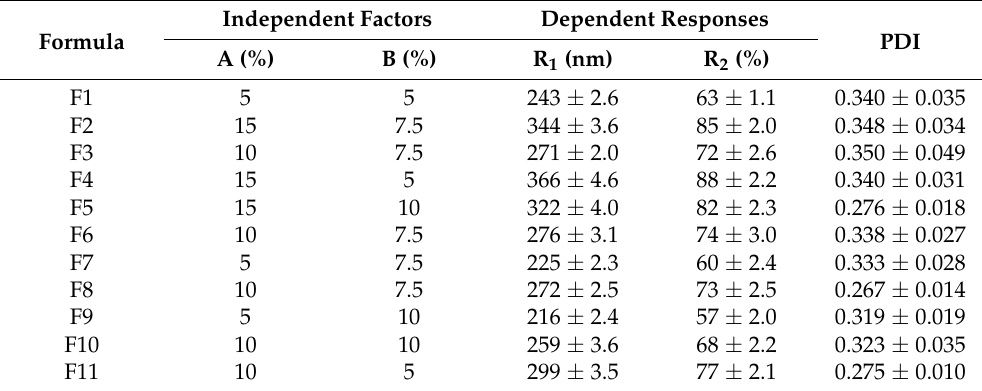
Table 1. Formulations of FA-SLN offered by CCD with their detected